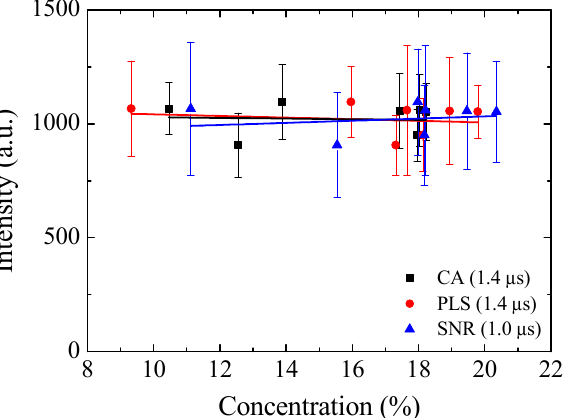
Figure 7. Correlation between the intensity and H concentration with maximum R 2 for CA, PLS, and SNR.